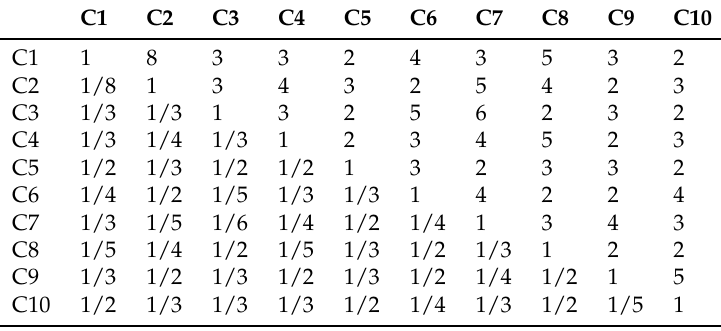
Table 5. Analytic Hierarchy Process (AHP)